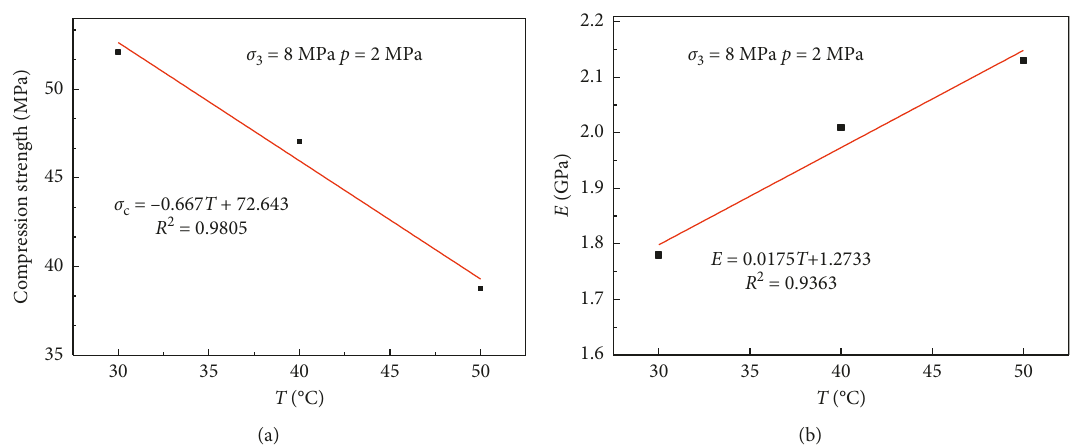
Figure 9: Relation between (a) compression strength and temperature and between (b) elastic modulus and temperature at a confining pressure of 8 MPa and pore pressure of